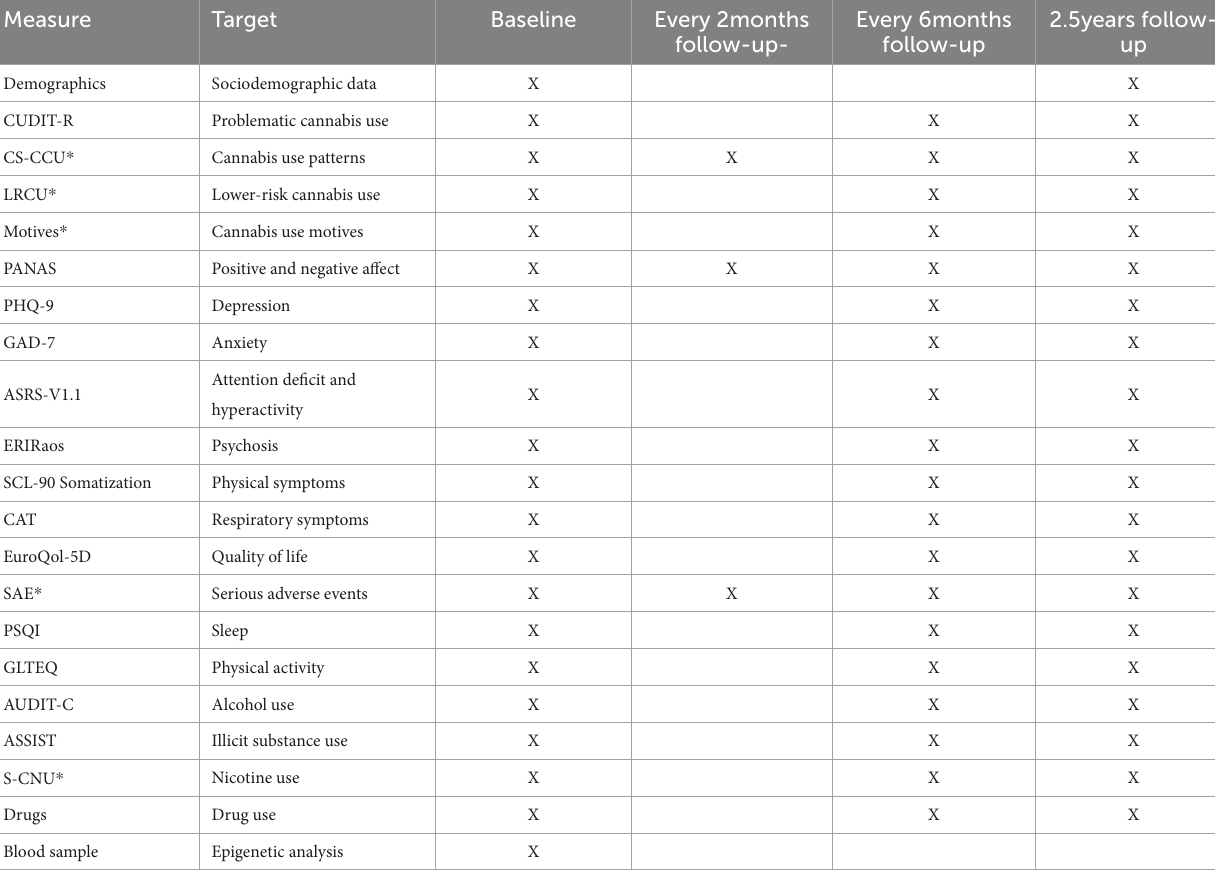
TABLE 1 Overview of all measures and their assessment